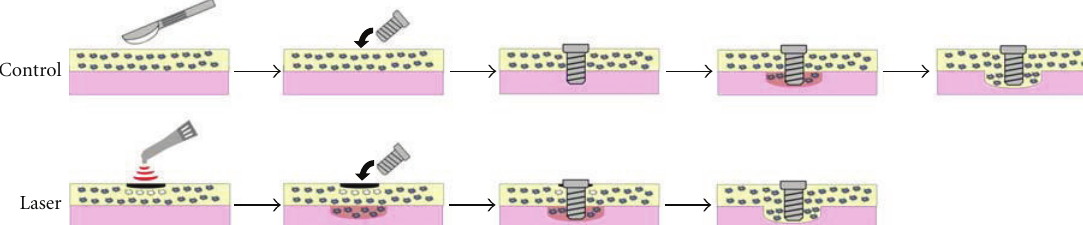
Figure 6: Summary of the healing processes in the control group and laser group. Laser irradiation-induced bone formation in the bone marrow and laser group showed earlier osseointegration. The control group also acquired osseointegration, but the healing period was longer than that of the laser